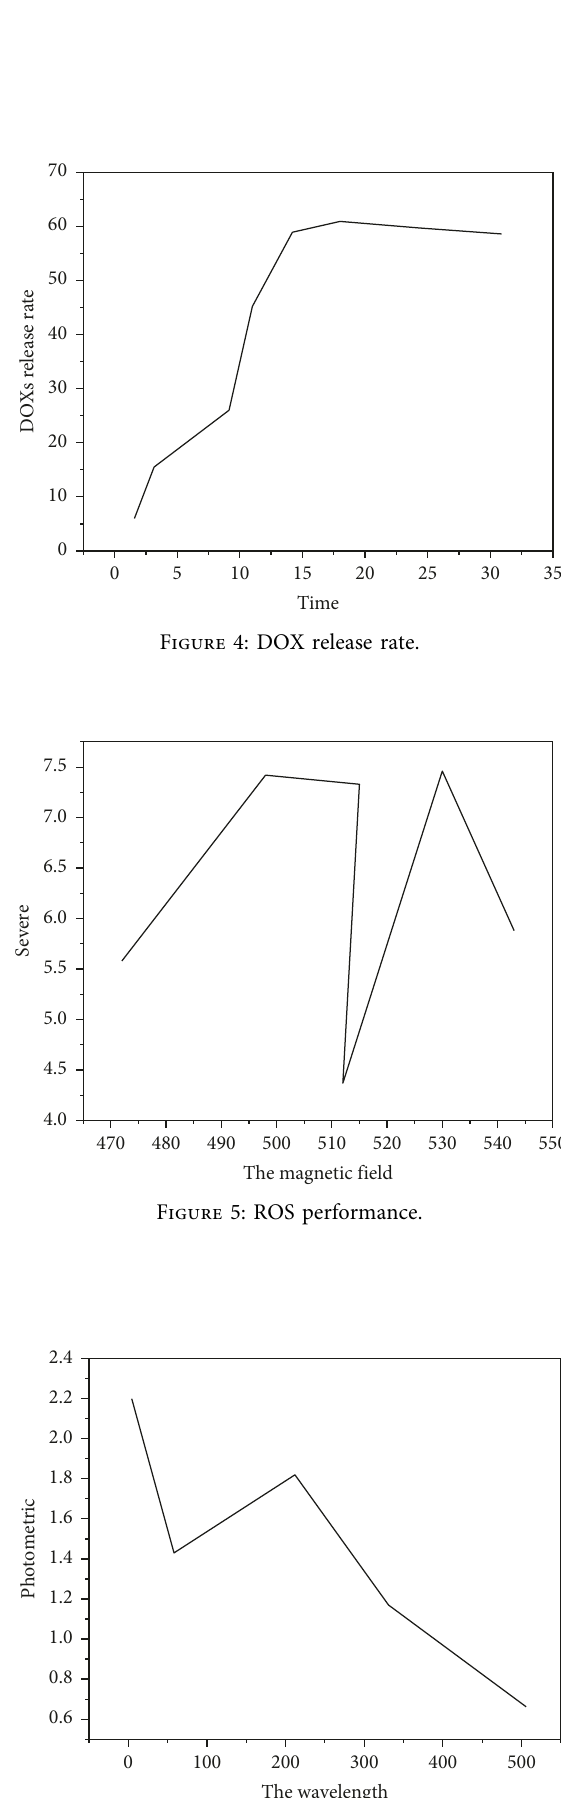
Figure 6: Singlet oxygen generation